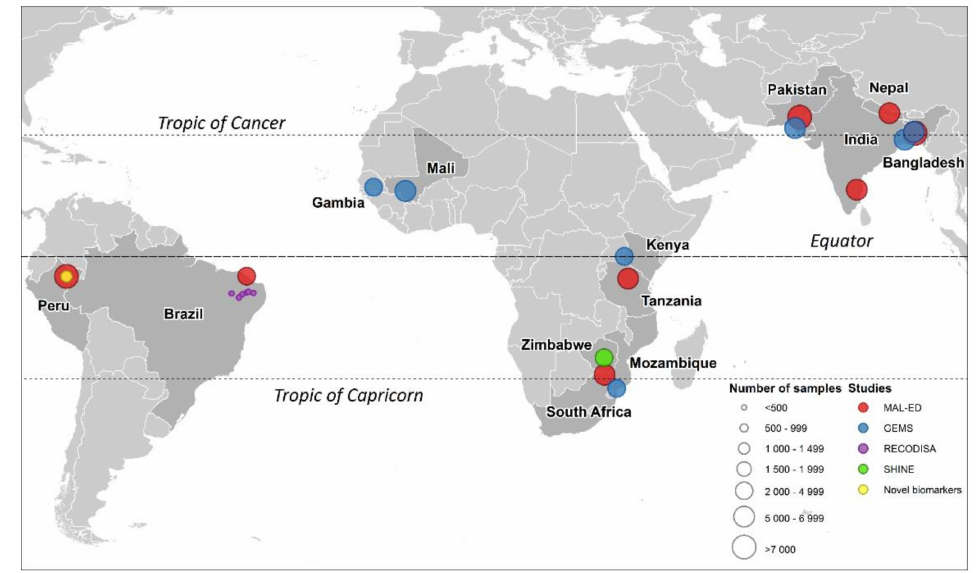
Figure 1. Locations of the 22 study sites in which the 5 studies were carried out and numbers of available stool samples (before exclusion of samples not diagnosed by